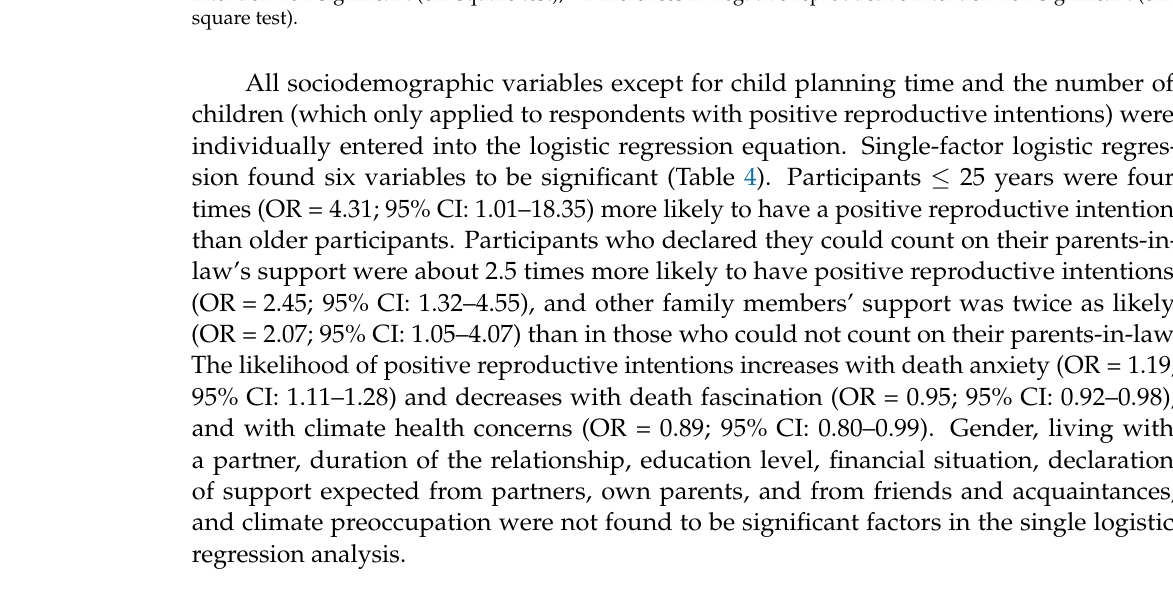
Table 4. Single-factor logistic regression model predicting positive reproductive intentions (N =